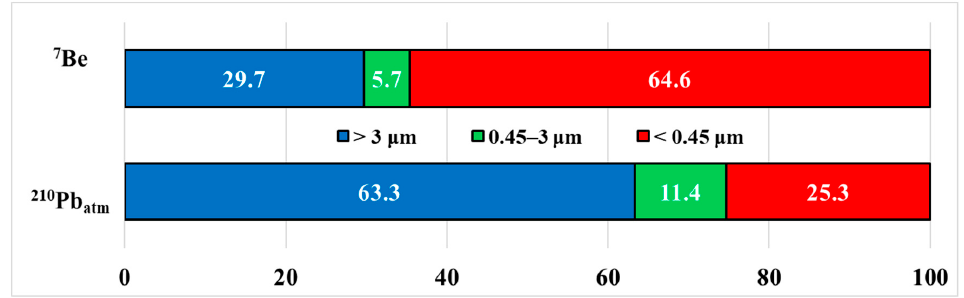
Figure 6. Averaged values of the suspended matter in snow water particulate fractions contribution (%) to the total activity of 7 Be and 210 Pb atm .